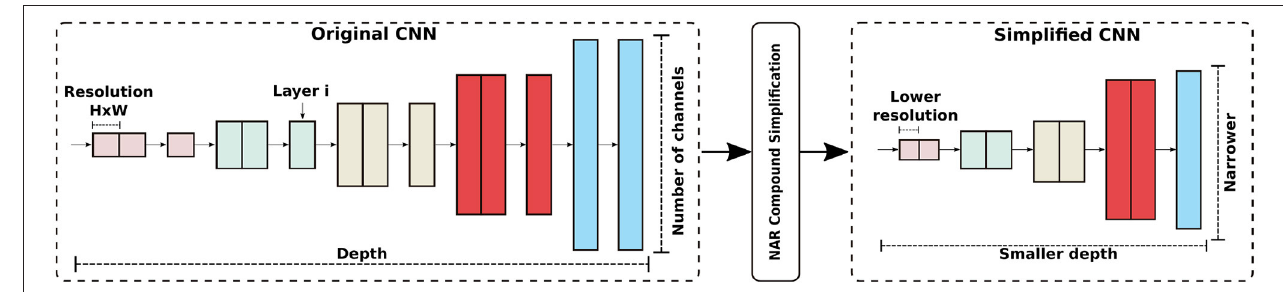
FIGURE 2 | NAR compound CNN simplification modifies depth, width, and input resolution in order to have a balance among CNN components.